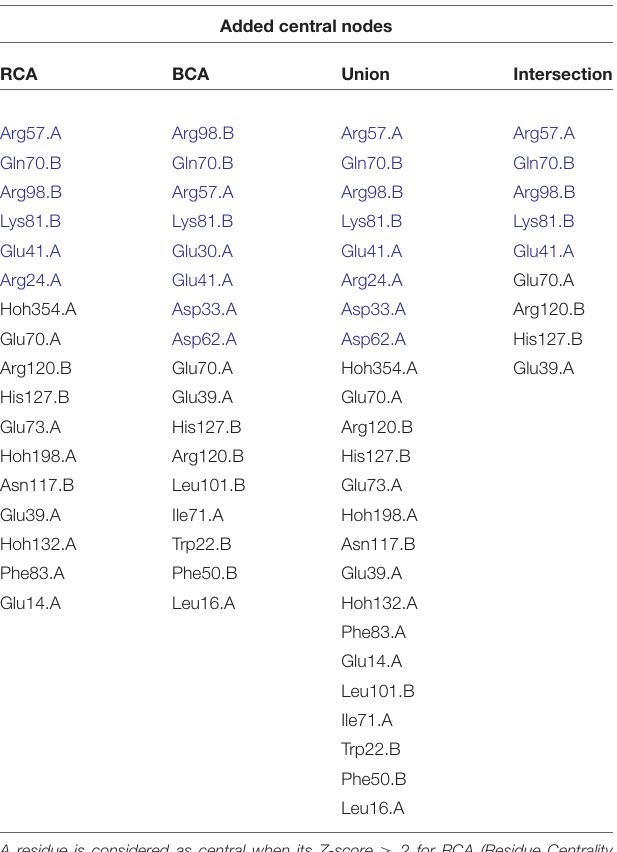
TABLE 1 | List of added central residues when considering water in the residue interaction network compared to without water, for E2/Im2 complex (chain A = Im2; chain B = E2)